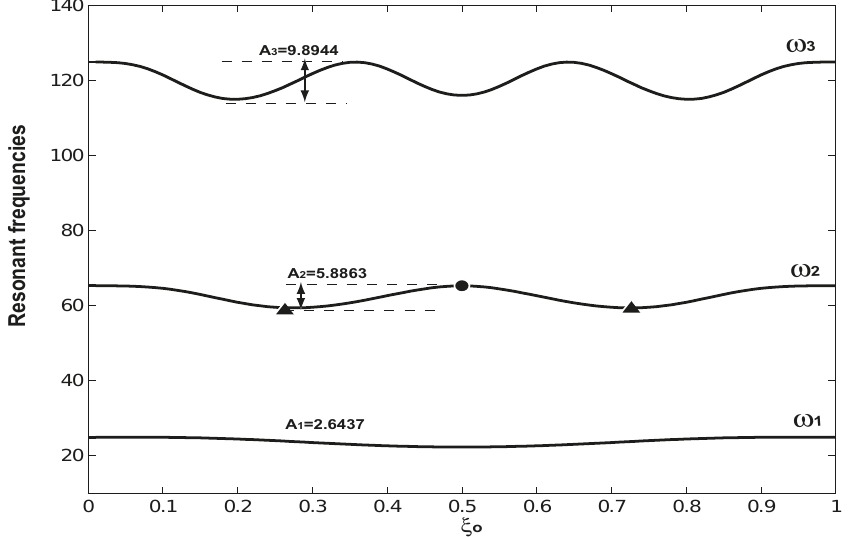
Figure 2. The variations of the first three resonant frequencies as the axial load ( β ) varies and 0 α = . At 2 4 β = − π , the first resonant frequency ( indicates buckling.